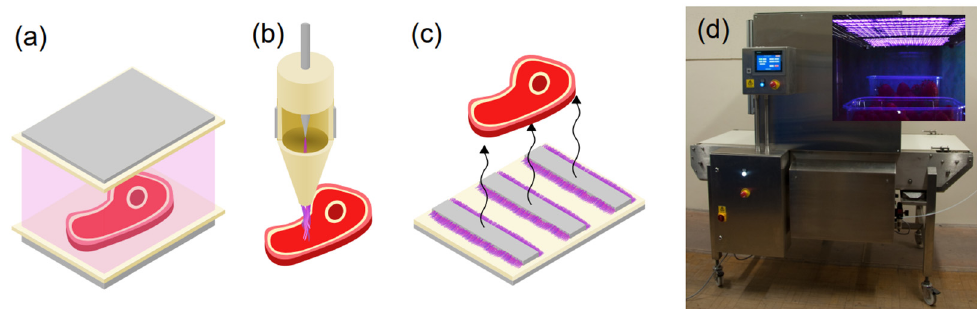
Figure 1. Typical DBD systems used for the treatment of food products: ( a ) direct-contact parallel plate reactor, ( b ) direct-contact plasma jet, ( c ) indirect contact surface barrier discharge and ( d ) pilot-scale surface barrier discharge system developed at the University of Liverpool.